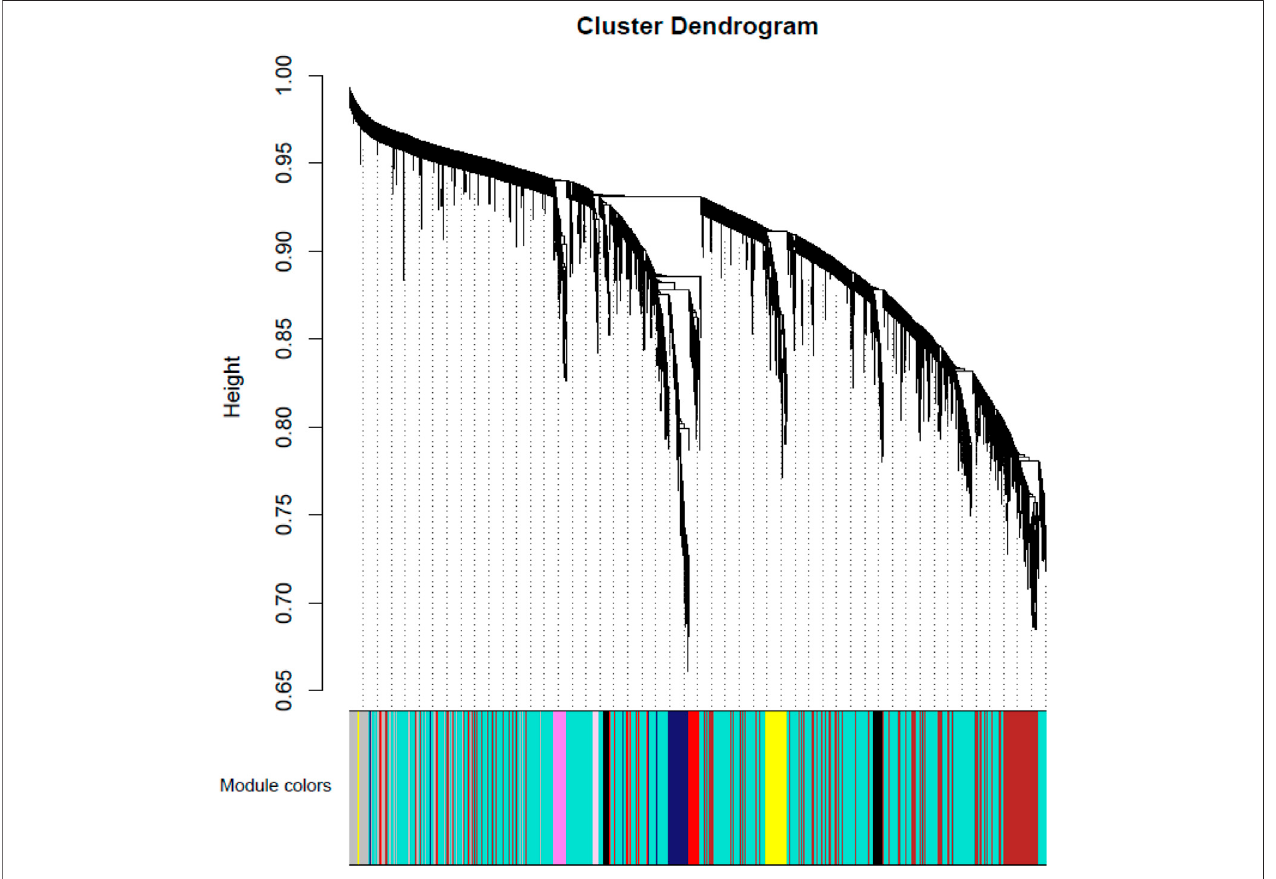
FIGURE1| Module-MDvs.Controlrelationship.Eachrowcorrespondstoamoduleeigengene.Eachcellcontainsthecorrespondingcorrelationinthe fi rstlineand the p -value in the second line. The table is color-coded by correlation according to the color legend. Among them, red represents a positive correlation and blue represents a negative